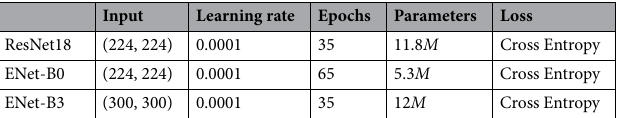
Table 3. Implementation details of both EfficientNet and ResNet